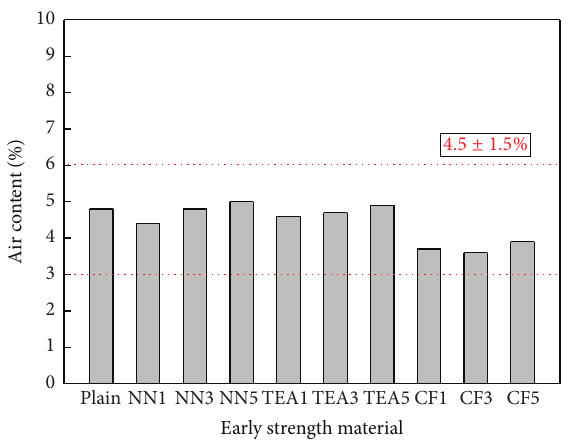
Figure 8: Relationship between slump and amount of shrinkage reducing agent.